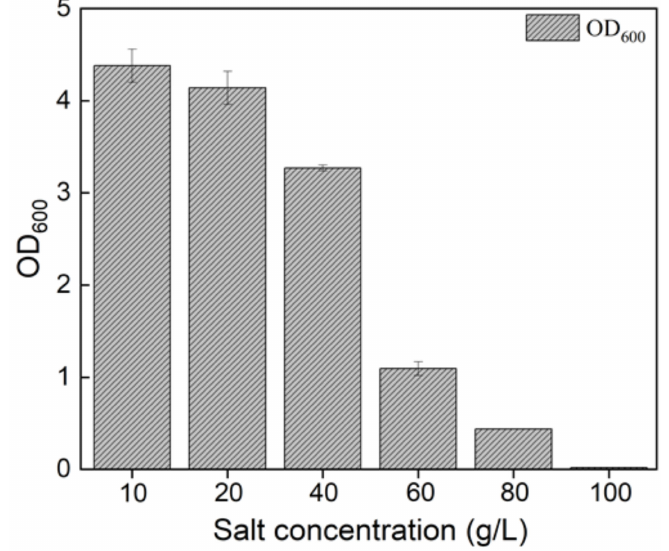
Figure 7. Salt stress test of Pseudomonas aeruginosa